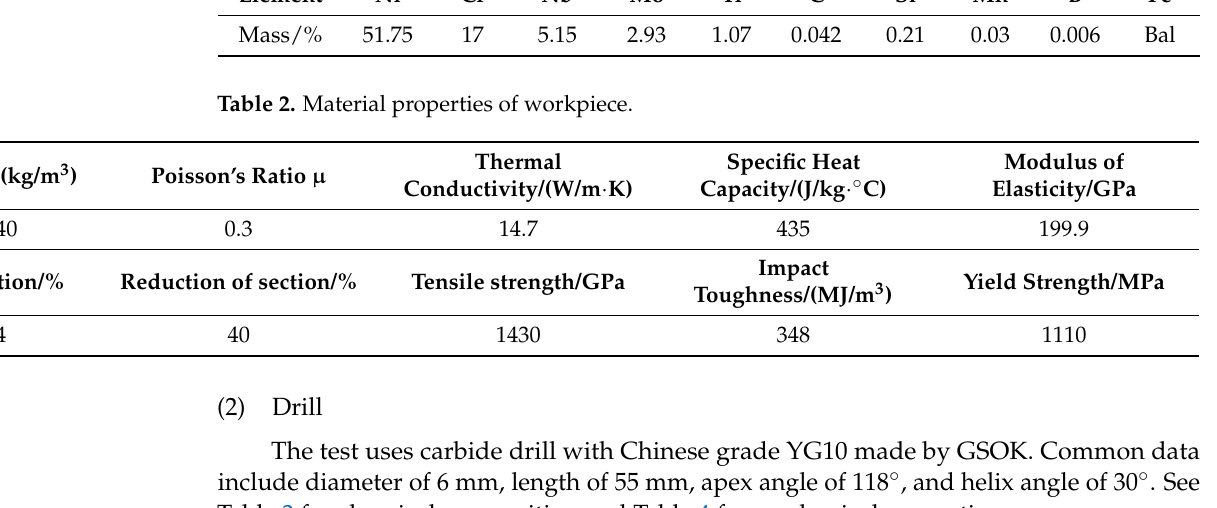
Table 3 for chemical composition and Table 4 for mechanical properties. Table 3. Chemical composition of carbide drill YG10.